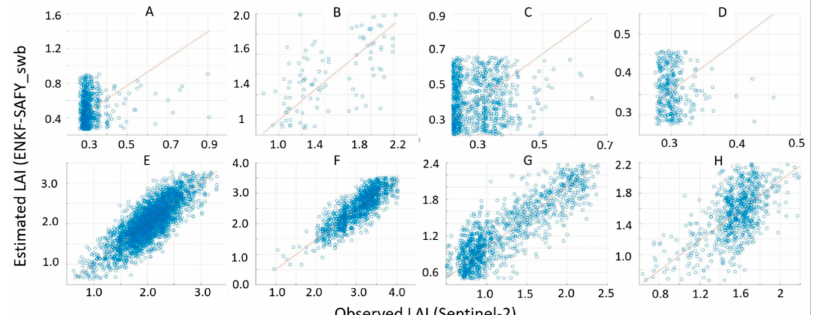
Figure 14. Comparison and linear regression between LAI estimated from Sentinel-2 data (horizontal axes) and LAI simulated by EnKF-SAFY_swb (vertical axis) for each group of fields (as classified in Section 2.3.1, each letter corresponds to a group of fields). ( A ) Group A; ( B ) Group B; ( C ) Group C;